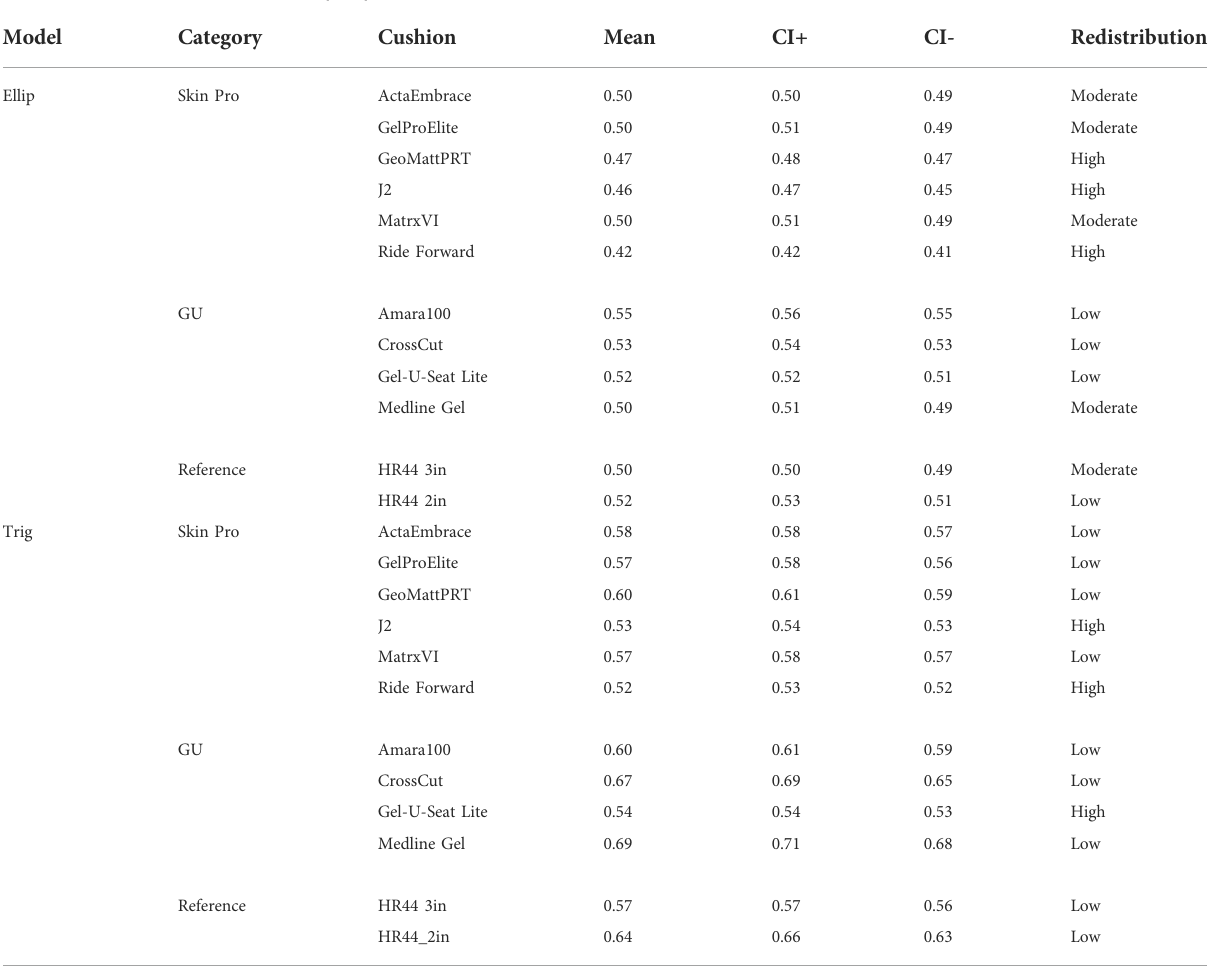
TABLE 4 Cushion classi fi cation based upon pressure redistribution.